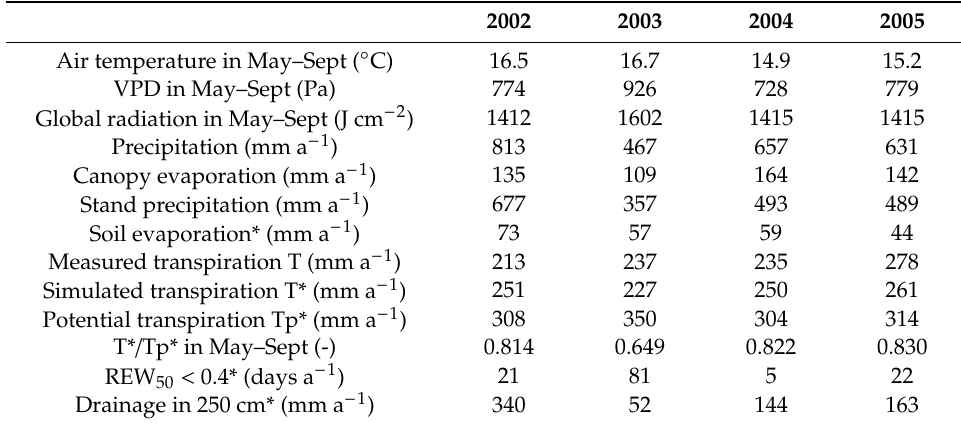
Table 2. Site conditions and water fluxes (mm a − 1 ) at the study site during the four years of investigation. Values based on simulation results are marked by an asterisk (*). REW 50 describes the number of days where the relative extractable water available in the top 50 cm of soil falls below